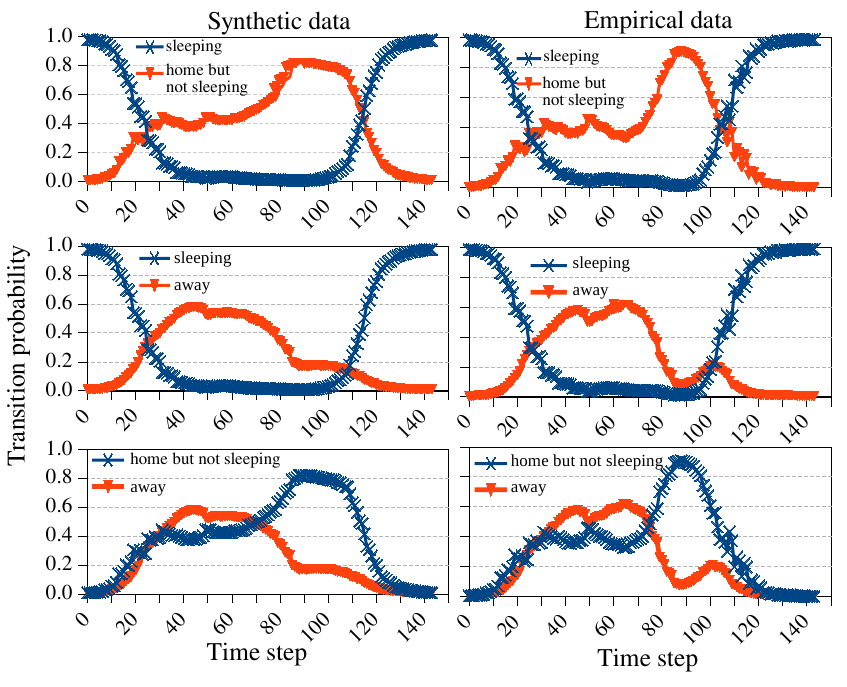
Figure 8. Comparison of state